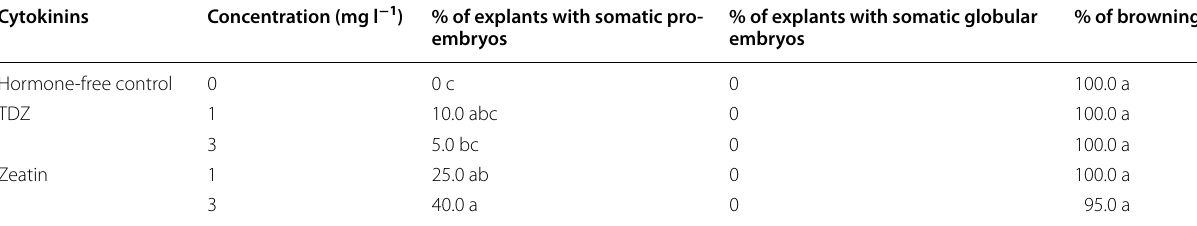
Table 4 Effects of TDZ and zeatin on direct somatic embryogenesis from leaf explants of Tolumnia Louise Elmore ‘Elsa’, when the explants were cultured in light condition for 90 days